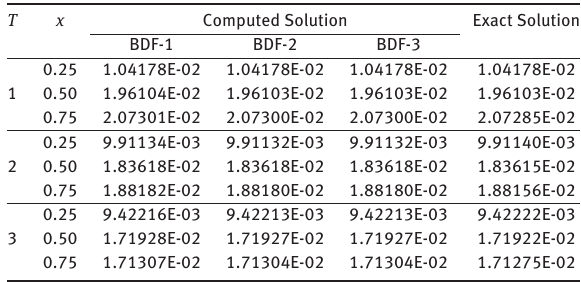
Table 12: Numerical solutions obtained by proposed schemes and the exact solutions for Example 3: ν = 0.00667 , Δx = 0.0125 and Δt = 0.001 .